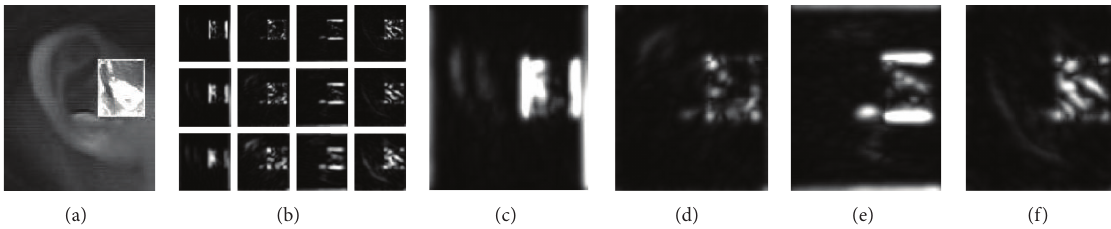
Figure 7: The process of Gabor orientation feature extraction from a randomly occluded test ear sample: (a) a 25% occluded test ear image from the first class of USTB ear database III. (b) Gabor filtering responses of the input ear sample; (c), (d), (e), and (f) present the Gabor orientation information across four different